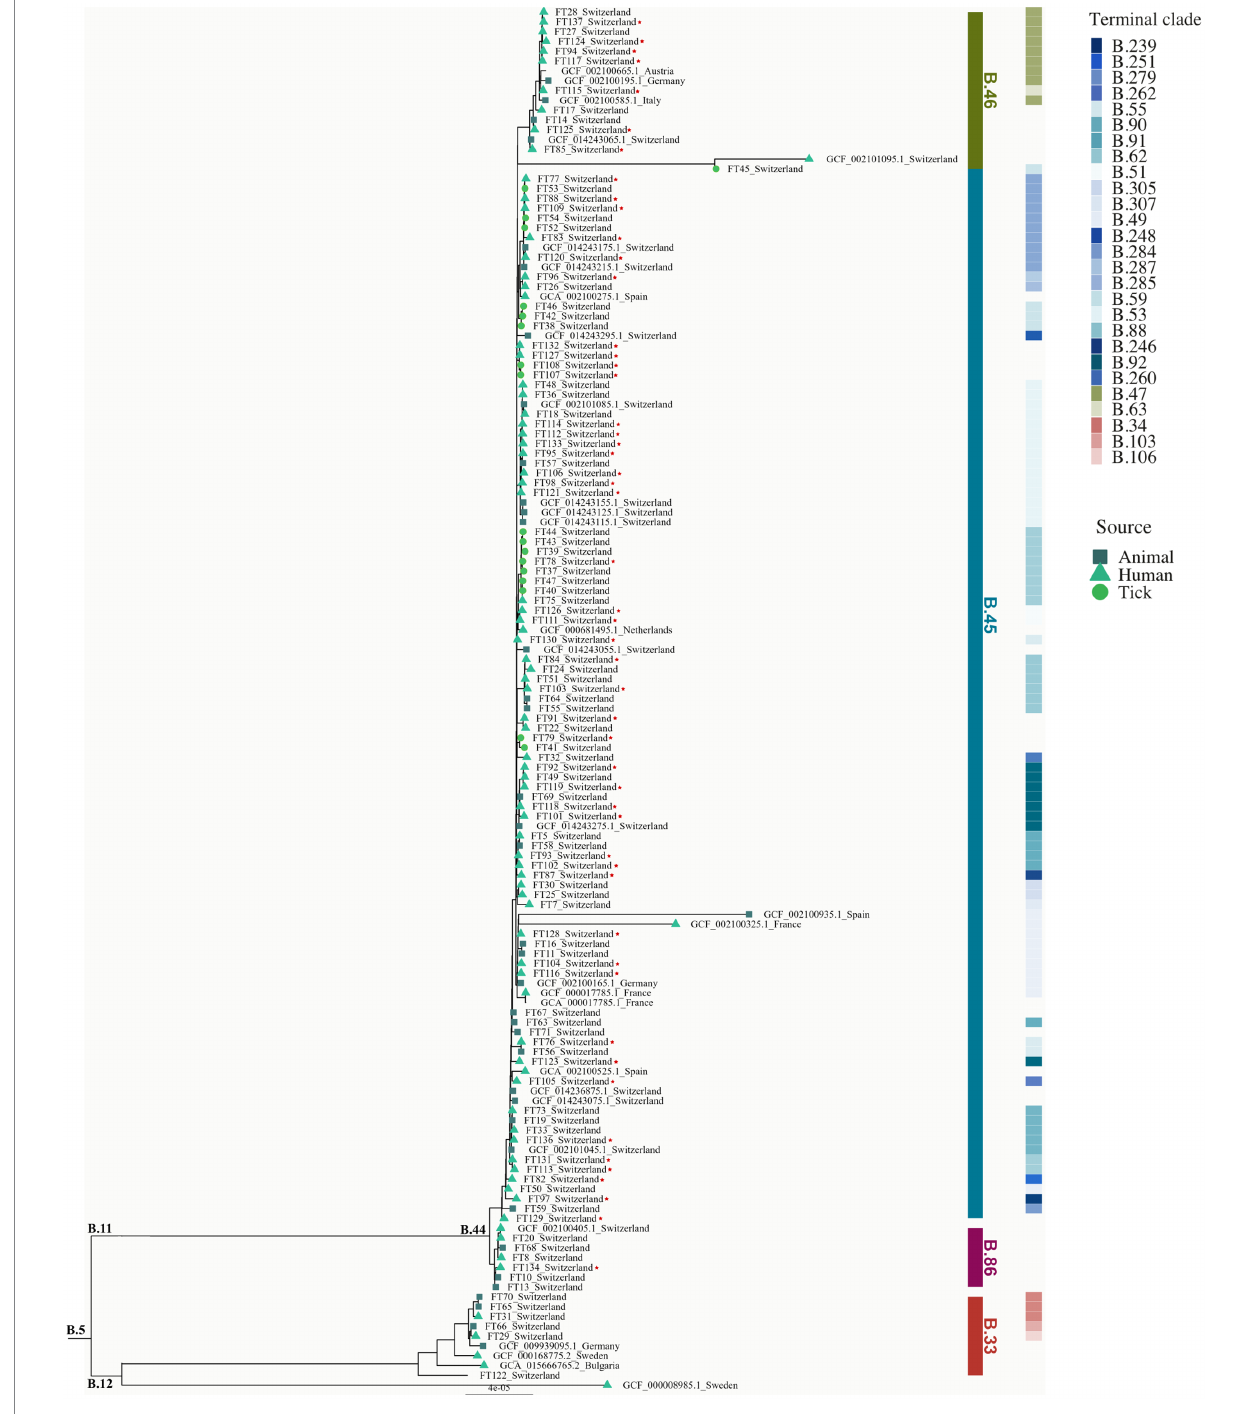
FIGURE 1 Phylogeny of Swiss Fth isolates. Phylogeny of Fth isolates ( n = 141) obtained from tick, animal, and human hosts (tick: circle; animal: rectangle; human: triangle). Reference genomes ( n = 15) from different European countries were included. Clades (B.33, B.86, B.45, and B.46) and terminal clades were labeled according to the canSNP nomenclature. The newly sequenced isolates ( n = 52) are marked with a star. The tree was rooted with the B.12 as out-group. The scale bar corresponds to the average number of substitutions per